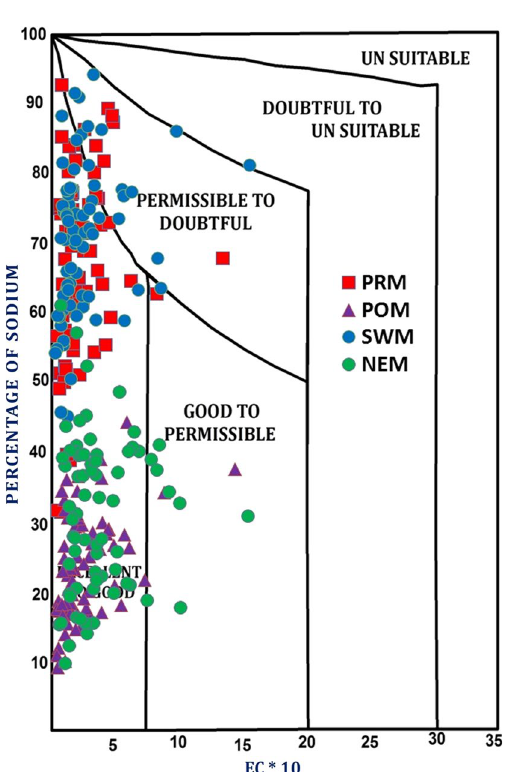
Fig. 8 Wilcox diagram representing irrigation quality of groundwater samples for the four